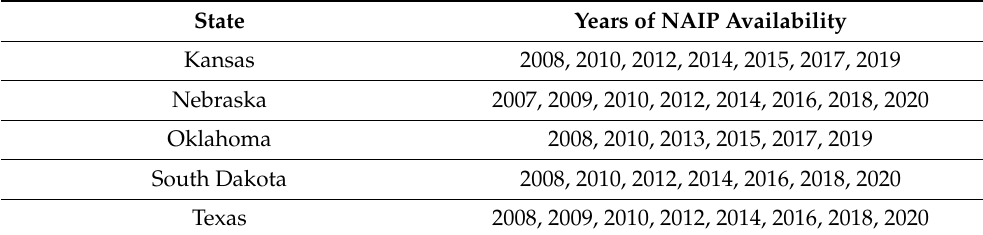
Table 2. Years of NAIP Availability for Each State with Potential Cropland Conversion